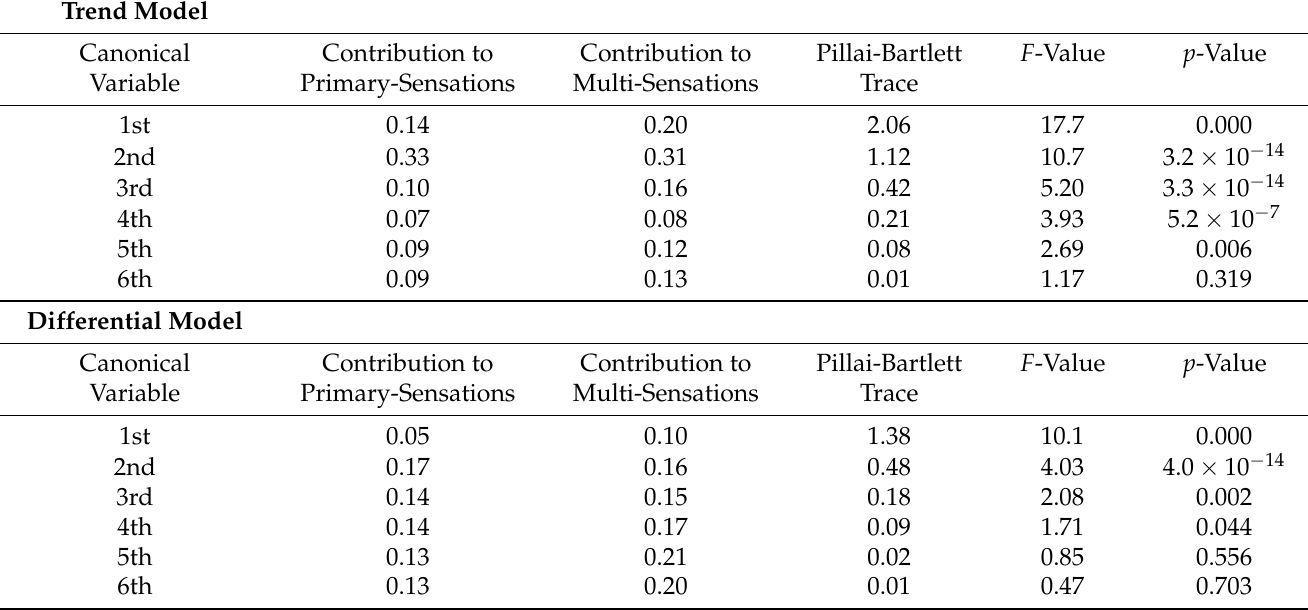
Table 3. Contribution of canonical variables to the sample variances in the (top) trend model and (bottom) differential model. The canonical variables are arranged in the order of correlation coefficients between the dominance proportions of primary- and multi-sensory